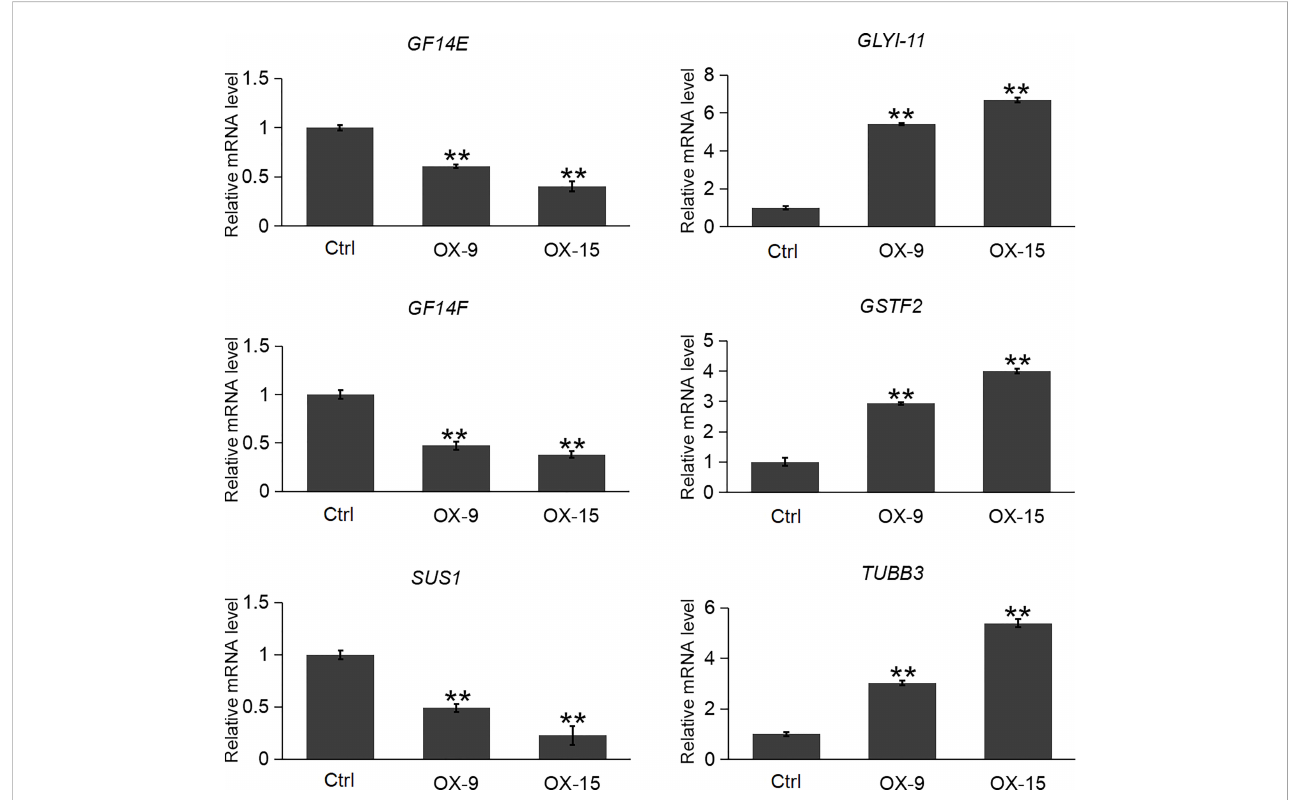
FIGURE 7 Expression analysis of several clients genes in the OsGF14C -OX transgenic plants and control plants (Ctrl) by quantitative real-time PCR. Error bars indicate the SD from three biological replicates and asterisks indicate statistically signi fi cant differences compared to the control plants ( t test, ** P